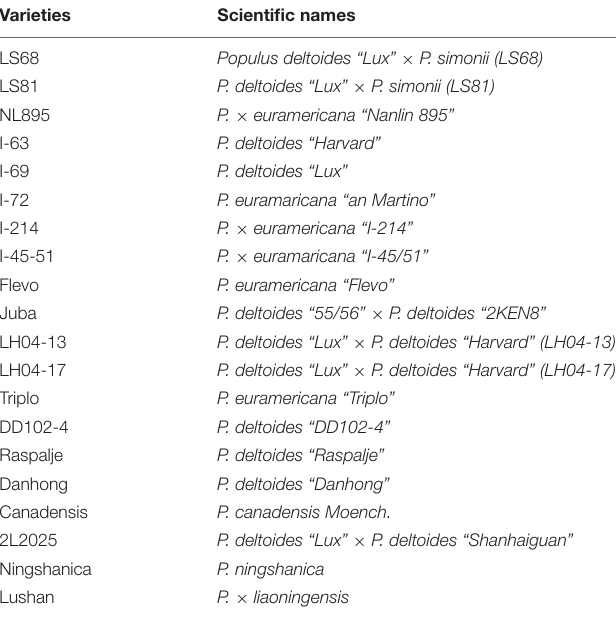
TABLE 1 | Scientific names of 20 poplar